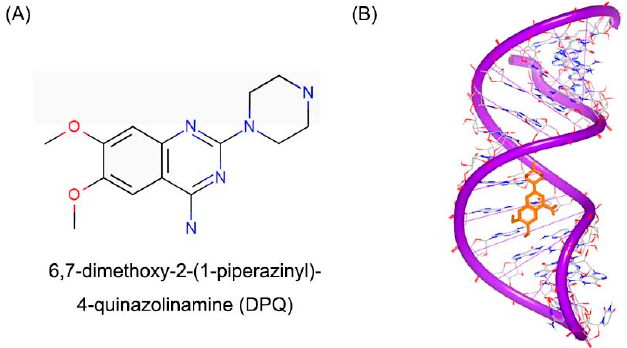
Figure 26. ( A ) Chemical structure of DPQ; and ( B ) structure of a RNA promoter complex with DPQ (PDB code: 2LWK). The orange structure represents the small molecule; the purple structure represents the backbone of nucleic acid; the blue and red atoms in the molecule represent nitrogen and oxygen atoms, respectively.